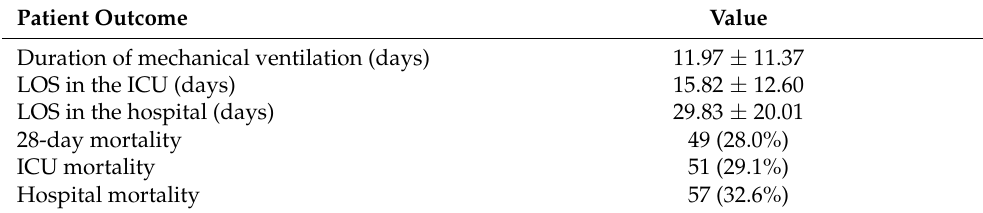
Table 2. Patient outcomes such as length of stay and mortality ( n =